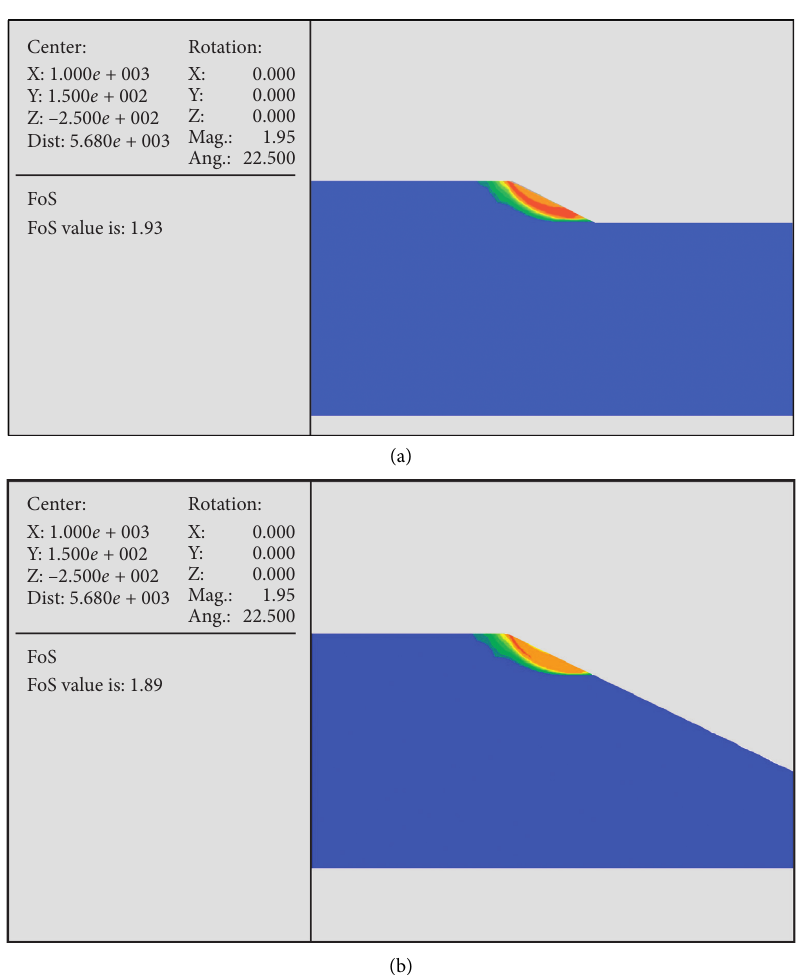
Figure 14: Numerical simulation results of slope stability evaluation. Stability evaluation of slope with slope excavation into (a) 4# coal seam and (b) 6# coal seam.